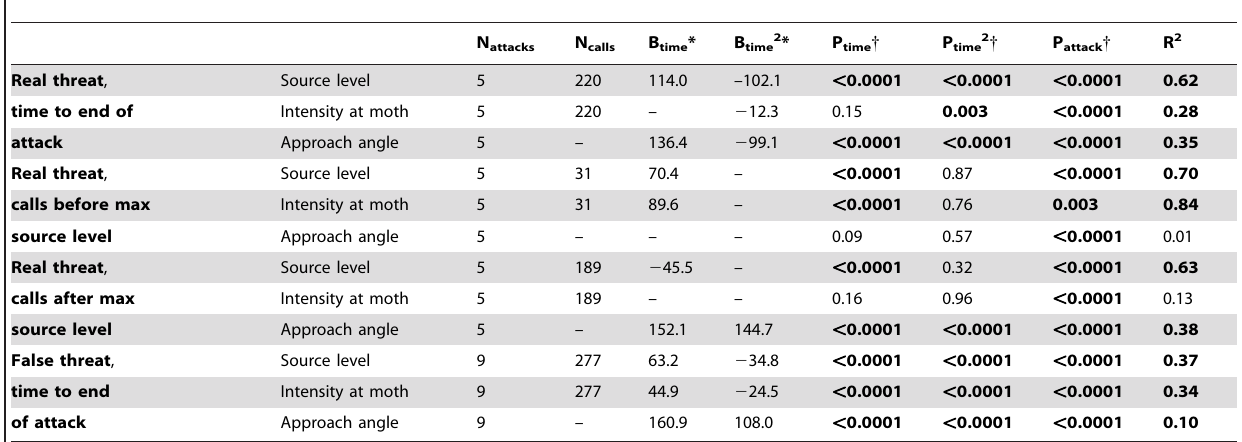
Table 1. Myotis call intensities and approach angles with respect to time for real and false